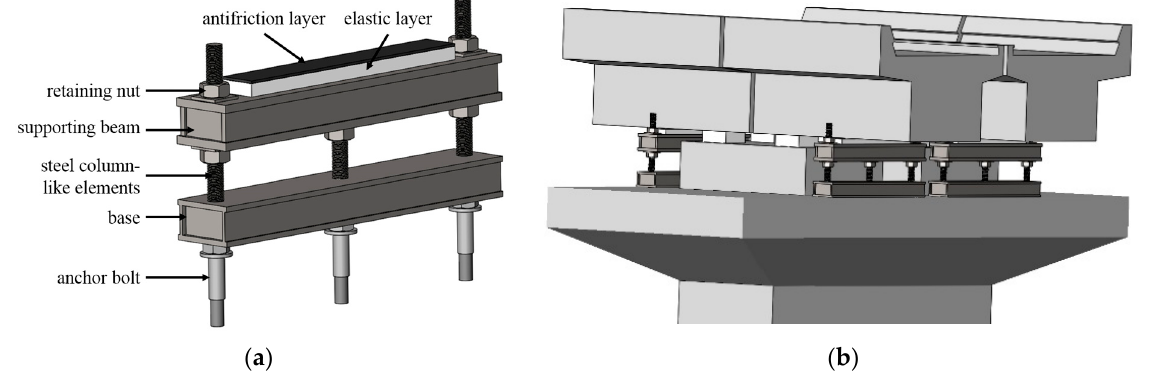
Figure 1. Schematic representation of the proposed NPSS. ( a ) Compositions; ( b ) installation.